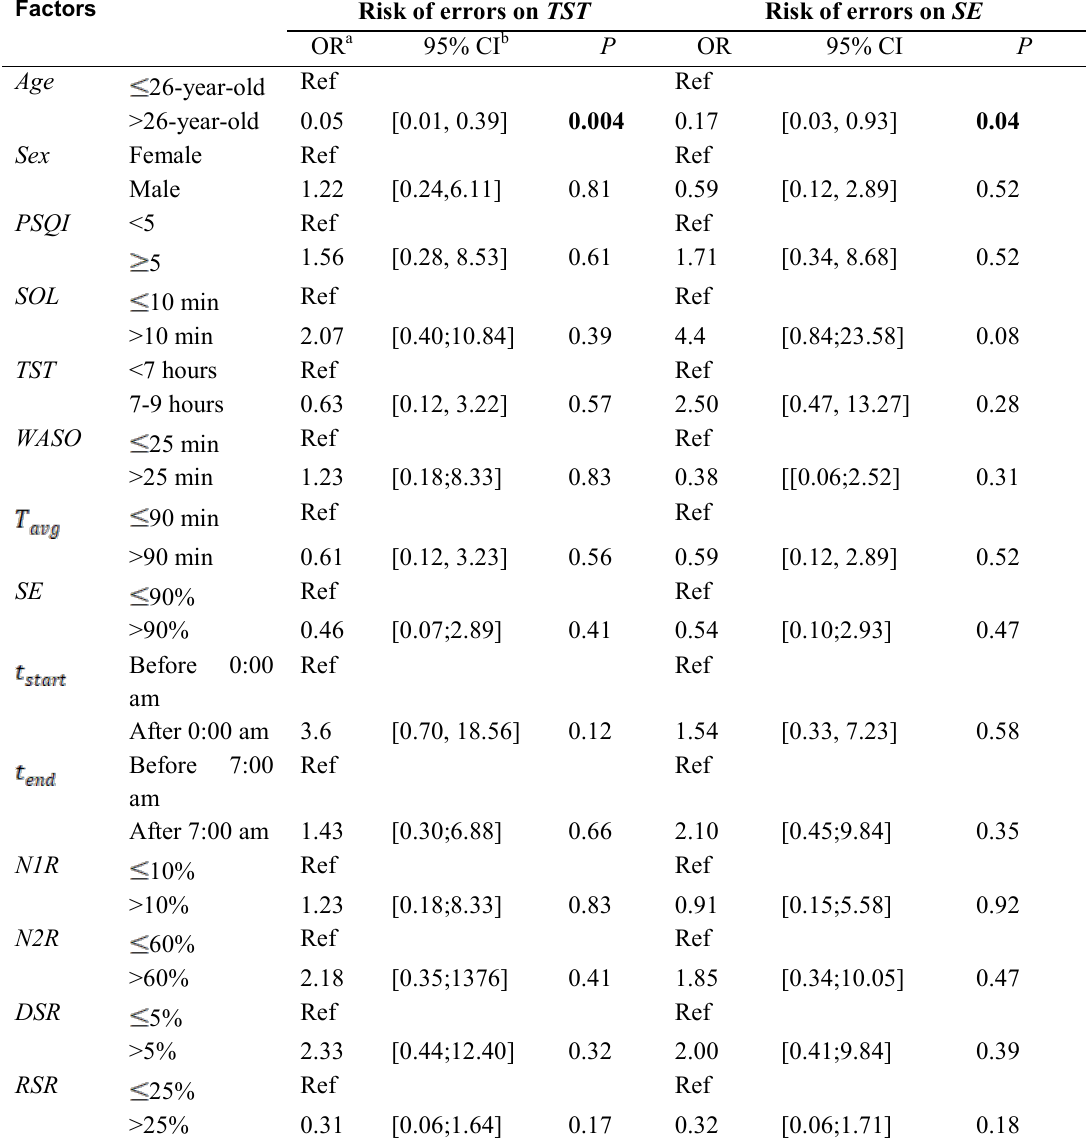
Table 5. Associations between user-specific factors and risk of measurement errors (Fitbit).